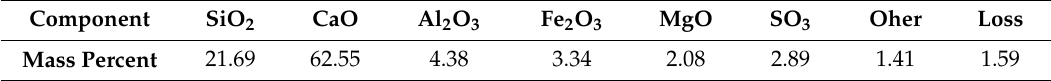
Table 2. Chemical composition of